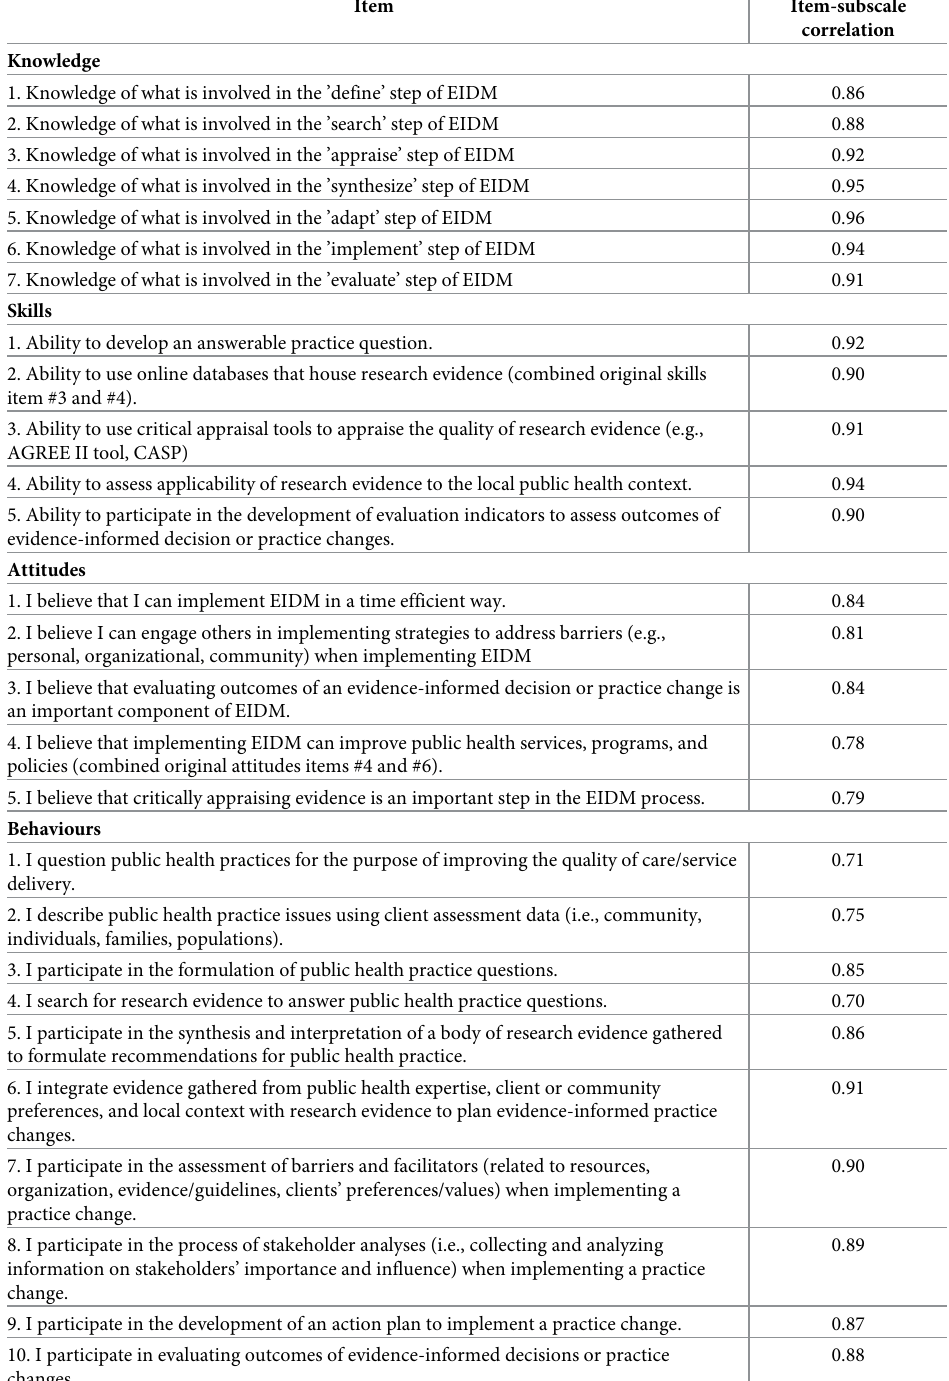
Table 5. Item-subscale total correlations for 27-item EIDM competence